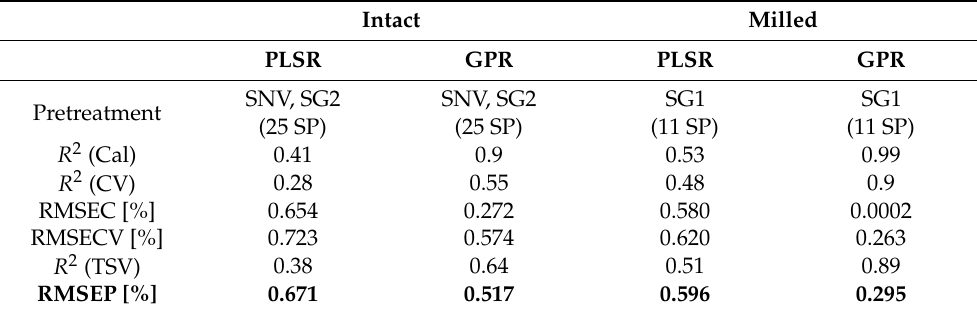
Table 4. Regression models constructed for the fused spectra from the miniaturized NIR spec- trometers (Tellspec Enterprise Sensor and SCiO Sensor) for the analysis of protein content (range: 19.3–23.0% ( w/w )) in intact and milled bars. Intact Milled